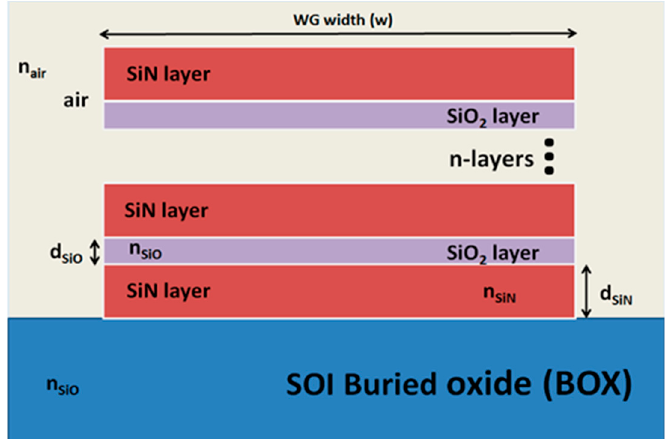
Figure 1. Cross section of the Waveguided model comprising some SiN/SiO 2 layers. During the simulation, we changed the number of layers, layer width (w), and layer thickness (dSiO, dSiN).